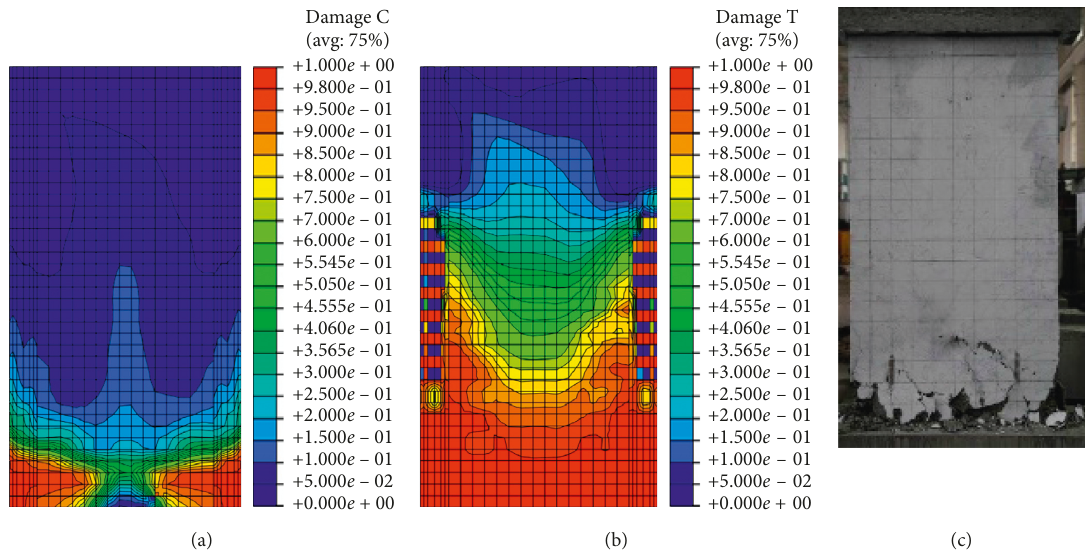
Figure 7: Predicted and test concrete damage of specimen GB2-3-1. (a) Concrete compressive damage. (b) Concrete tensile damage. (c) Test failure.